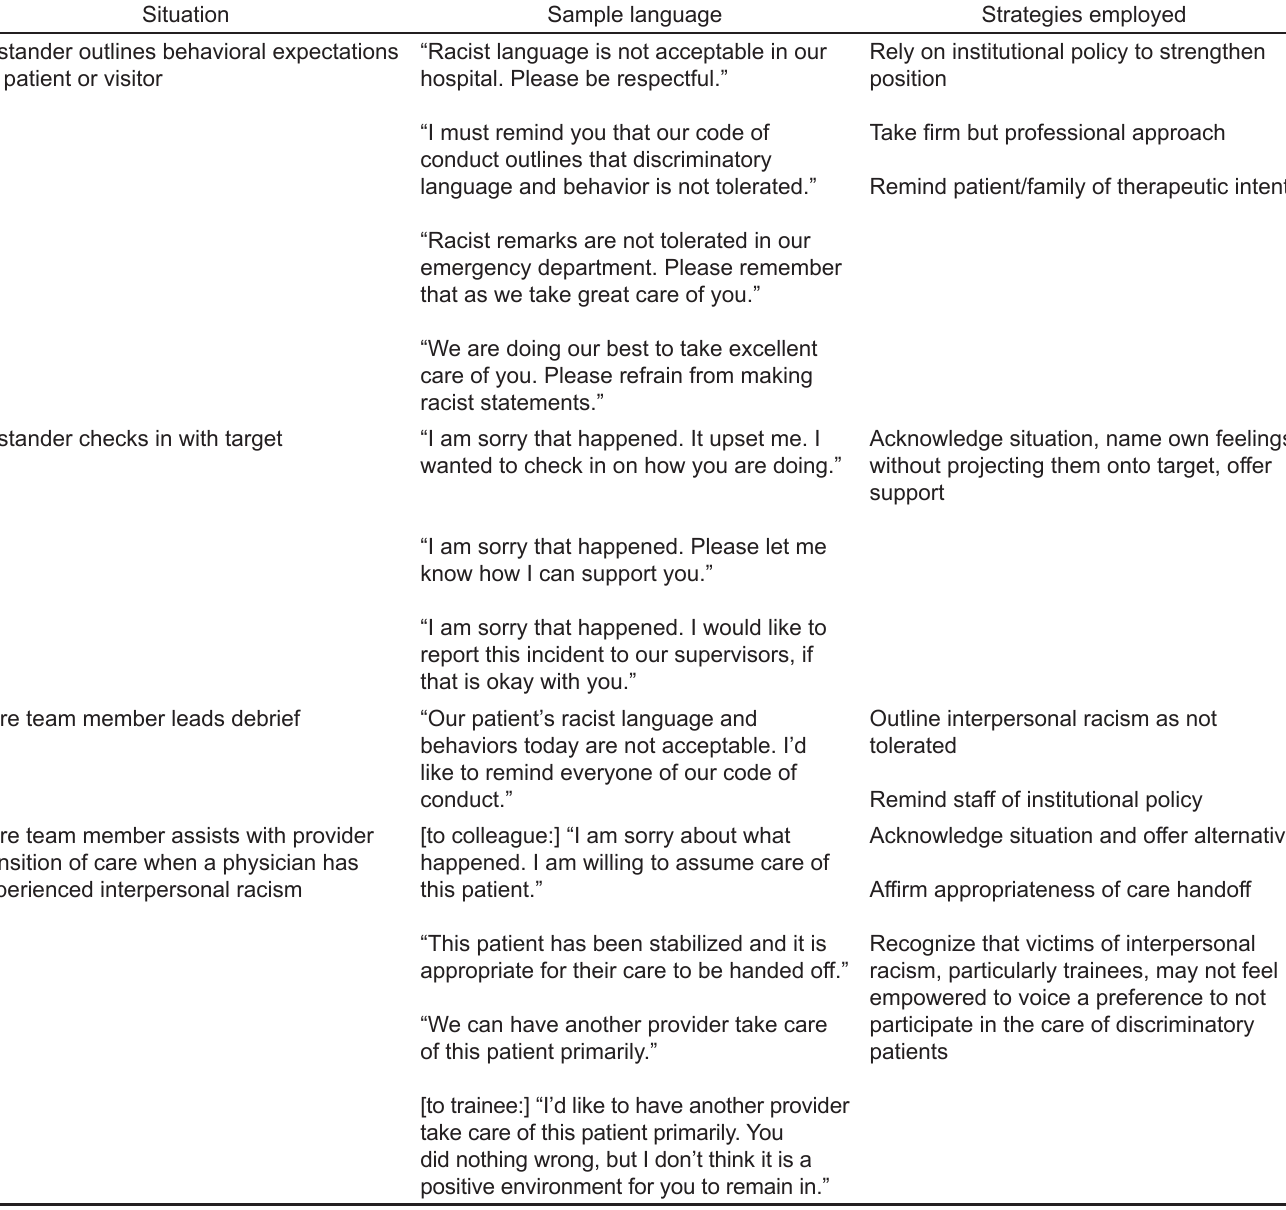
Table. Sample language for addressing interpersonal racism from